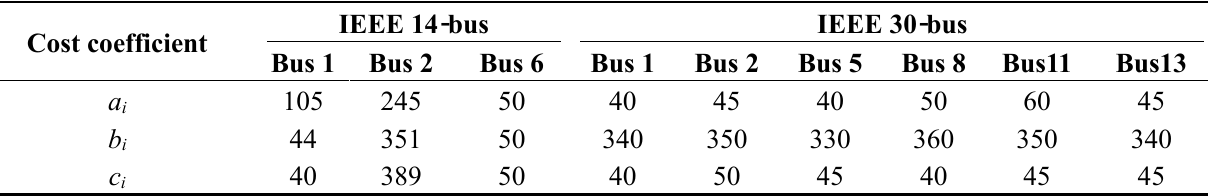
Table 3. The generator cost coefficient of the IEEE 14-bus and 30-bus test systems.